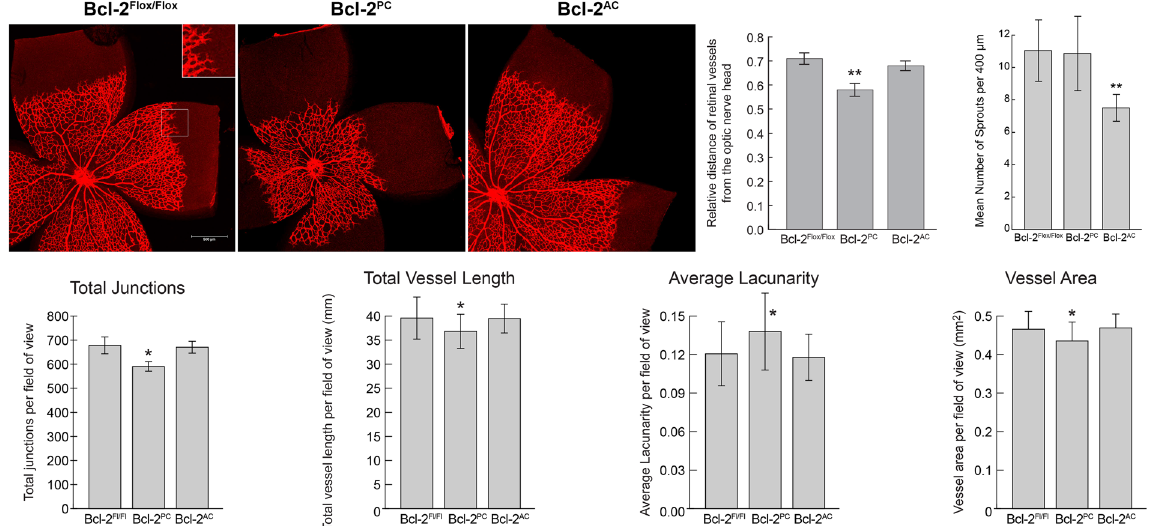
Figure 4. Bcl-2 PC mice demonstrate reduced distance of migrating front from the optic nerve. Retinas from P5 mice were wholemount stained with anti-collagen IV and the distance retinal vessels spread relative to the radius of the retina assessed in each quadrant (n = 5; ** P < 0.01). The inset magnifies (200%) the sprouting at the vascular front in the boxed area. Tip cell and junction numbers as well as lacunarity, vessel length and vessel area were also determined. Scale bar = 500 µ m. Please note that the distance the retinal vessels spread was decreased in Bcl-2 PC mice compared to Bcl-2 Flox/Flox and Bcl-2 AC